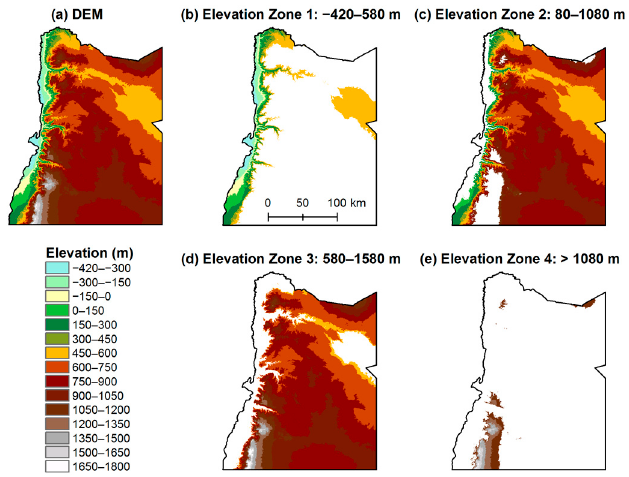
Figure 4. The discretization of ( a ) the digital elevation model into ( b – e ) four overlapping elevation